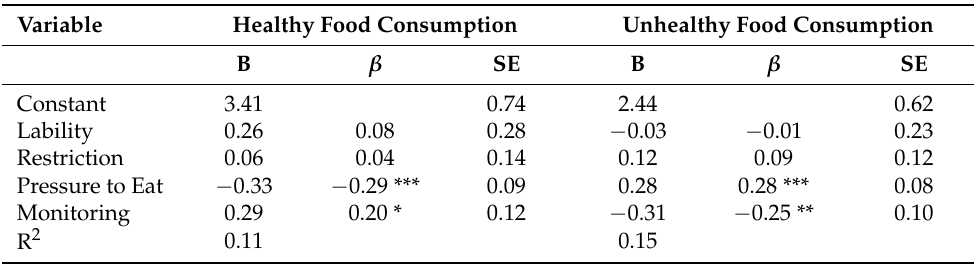
Table 3. Regression coefficients of child emotion regulation and parenting feeding practices for both healthy and unhealthy food consumption. Variable Healthy Food Consumption Unhealthy Food Consumption B β SE B β SE Constant 3.41 0.74 2.44 0.62 Lability 0.26 0.08 0.28 − 0.03 − 0.01 0.23 Restriction 0.06 0.04 0.14 0.12 0.09 0.12 Pressure to Eat − 0.33 − 0.29 *** 0.09 0.28 0.28 *** 0.08 Monitoring 0.29 0.20 * 0.12 − 0.31 − 0.25 ** 0.10 R 2 0.11